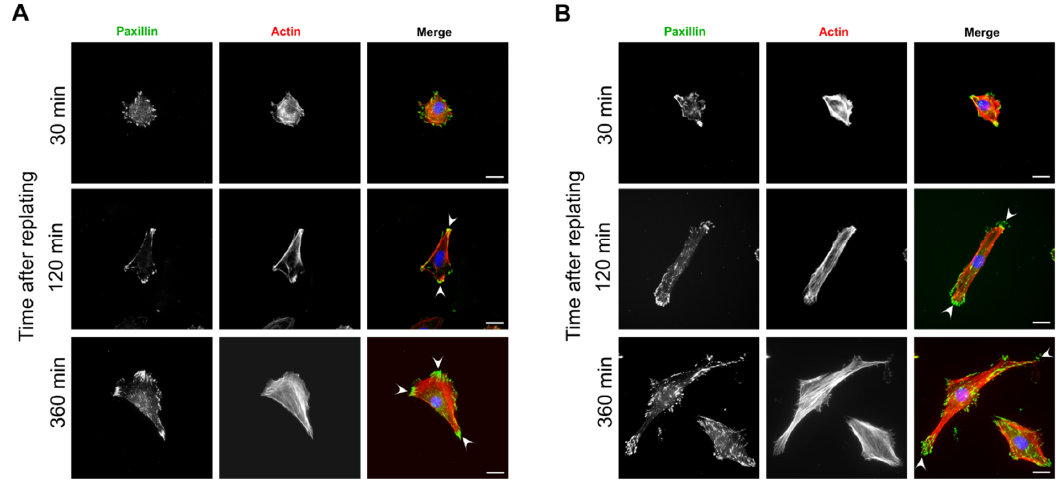
Figure 6. Focal adhesions and actin organization in FAK-depleted cells spreading on fibronectin. Representative fluorescence microscopy images of control ( A ) and FAK deficient cells ( B ) stained for paxillin (green) and actin (red) . Rat2 cells were transfected as in Figure 2A and replated on fibronectin-coated coverslips for the indicated times. The arrowhead in ( A ) indicates elongated, clustered focal adhesions at the presumed cell rear of a control cell. The arrowhead in ( B ) indicates focal adhesion organization at the pole of a FAK-depleted cell. Scale bars 20 μm.